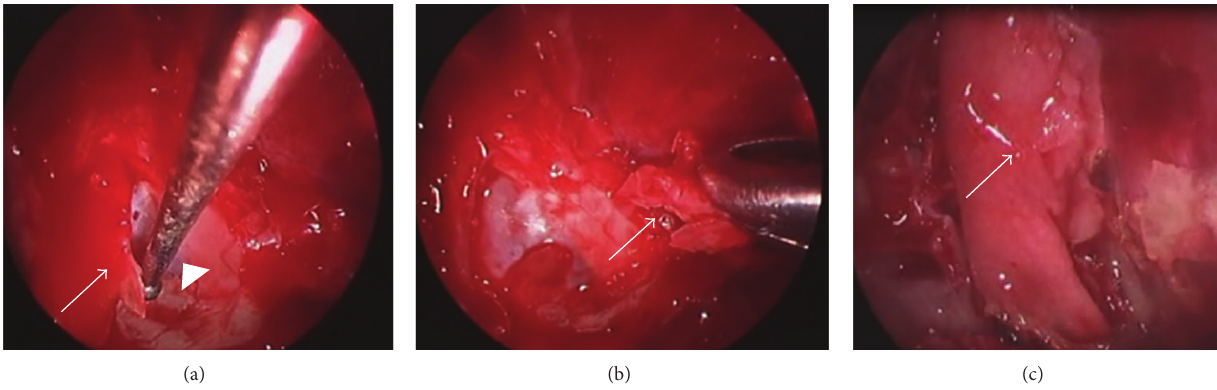
Figure 2: Intraoperative findings in case 1. (a) Only the cribriform plate (white arrow) was removed; biopsy of the dura mater (white arrowhead) was not performed. (b) It was confirmed through rapid intraoperative diagnosis that there was no obvious tumor infiltration in the cribriform plate mucosa, including a part of the olfactory glomeruli (white arrow), after tumor resection. (c) The dura mater was covered using a pedicled nasal septal flap (white arrow).